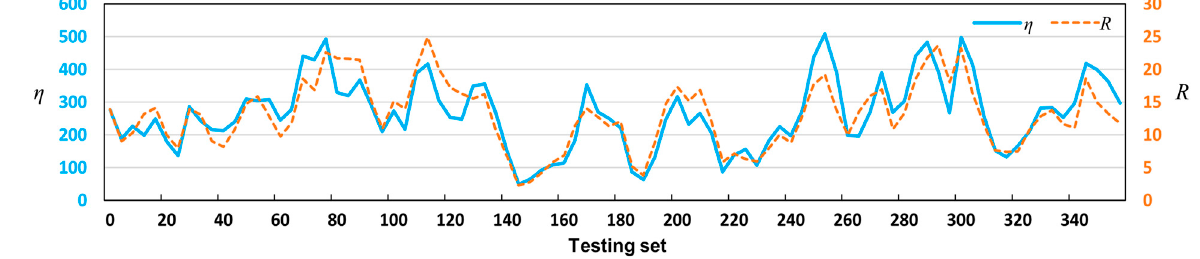
Figure 9. The puri fi cation e ffi ciency factor η and the synthesized puri fi cation factor R over the hours Figure 9. The purification efficiency factor η and the synthesized purification factor R over the hours of the testing set for the WWTP. of the testing set for the